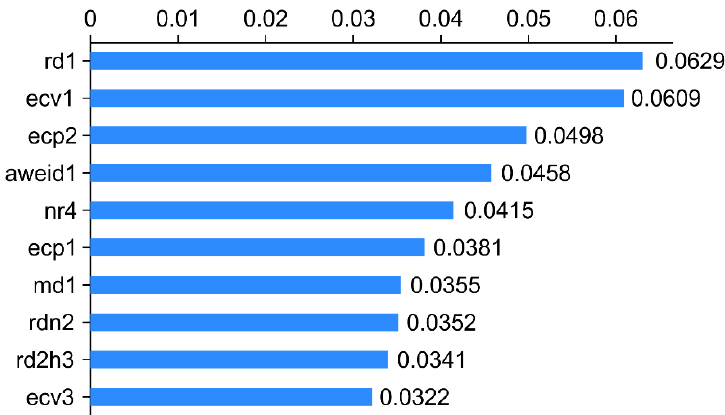
Figure 4. Importance of the features for the ten variables in Adaboost classification. Figure 5. Receiver operating curve (ROC) of train data (75%) and test data (25%) of the Rpart algo- rithm.